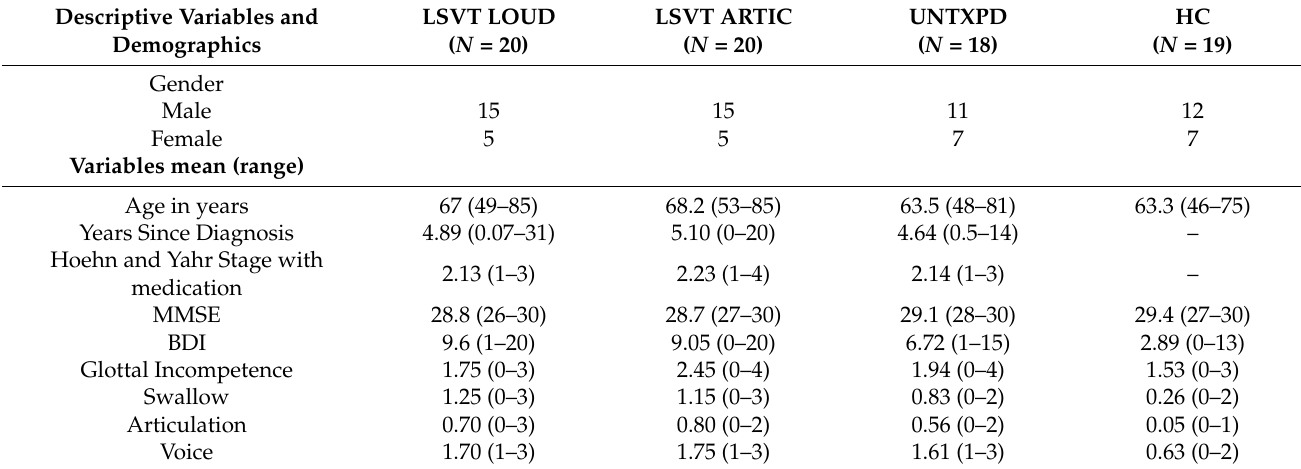
Table 1. Participant Descriptive Statistics.